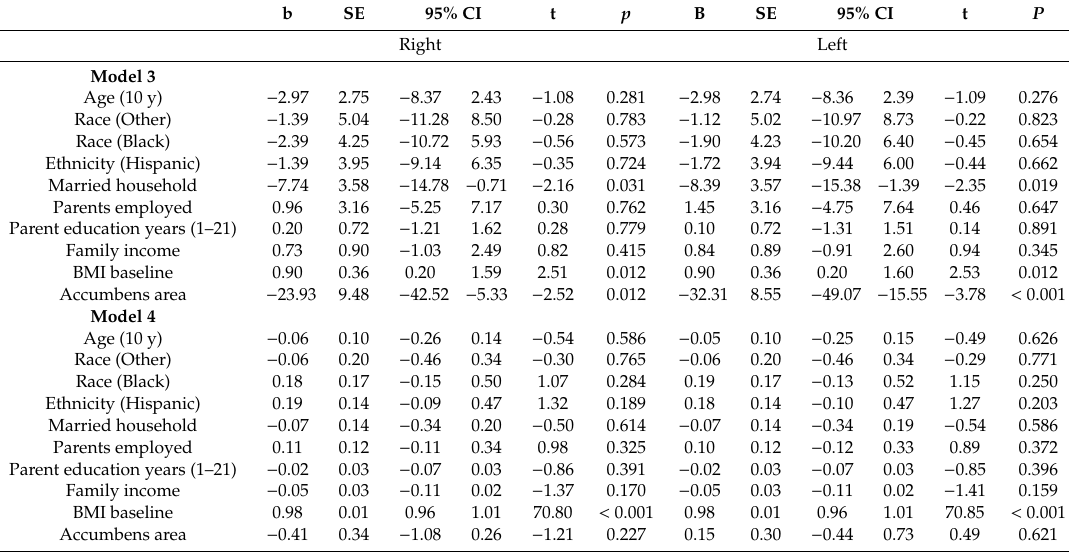
Table 4. Sex-specific regression